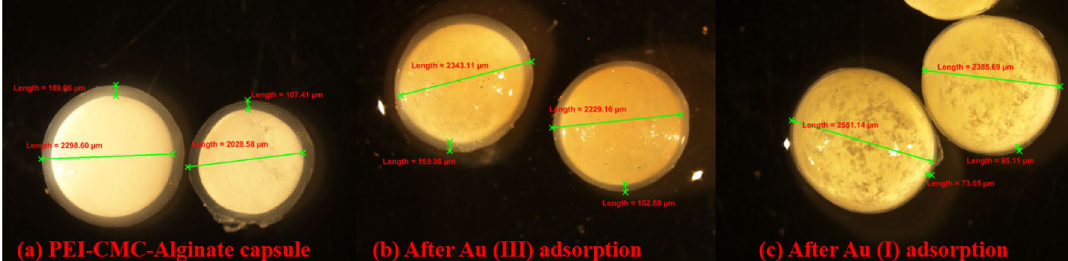
Figure 5. Light Microscopic image of ( a ) PEIIAC, ( b ) after Au (III) adsorption, and ( c ) after Au (I)